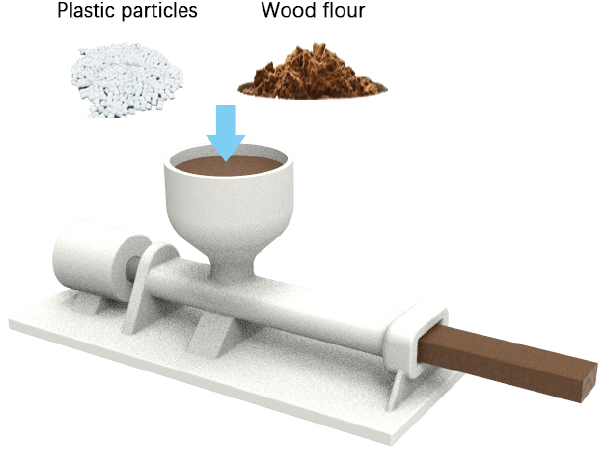
Figure 1. The extrusion process.